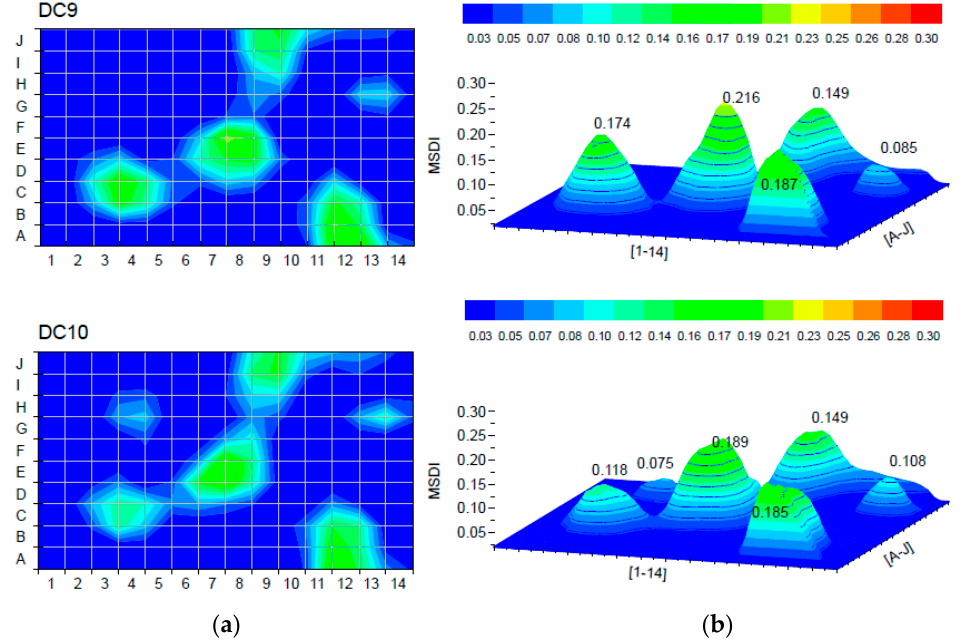
Figure 11. Damage localization for damage cases DC9 and DC10: ( a ) 2D; ( b ) peak values in 3D.